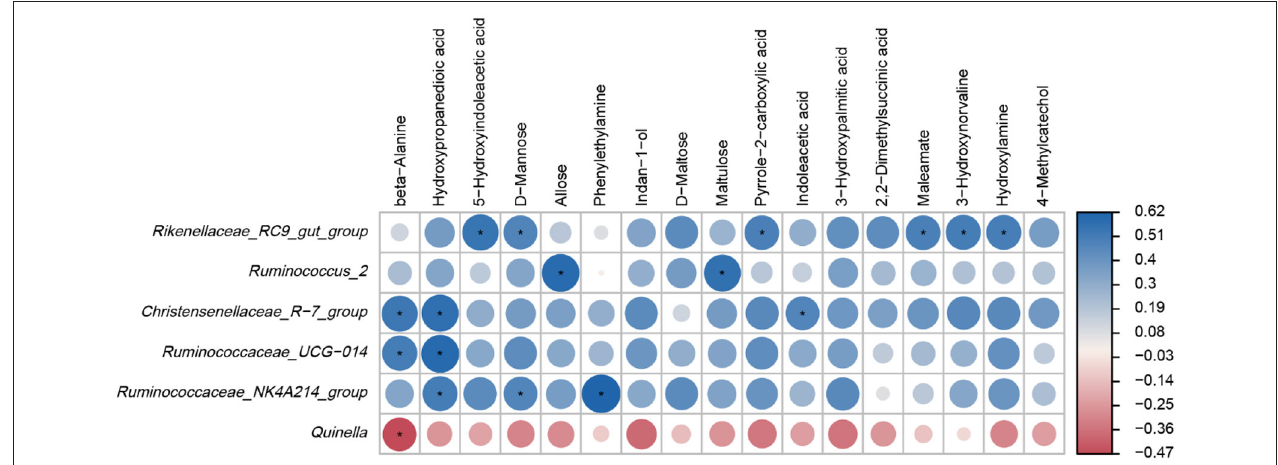
FIGURE 6 | Heatmap of Spearman correlations between main genera and differential metabolites. * p <